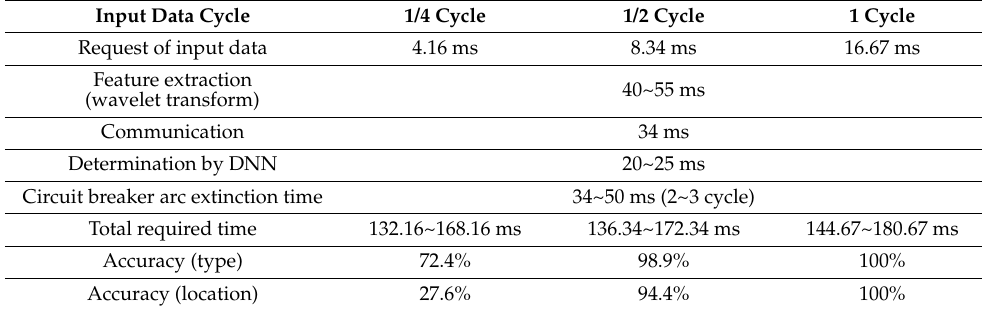
Table 4. Comparison of open conductor fault detection algorithm by number of input data